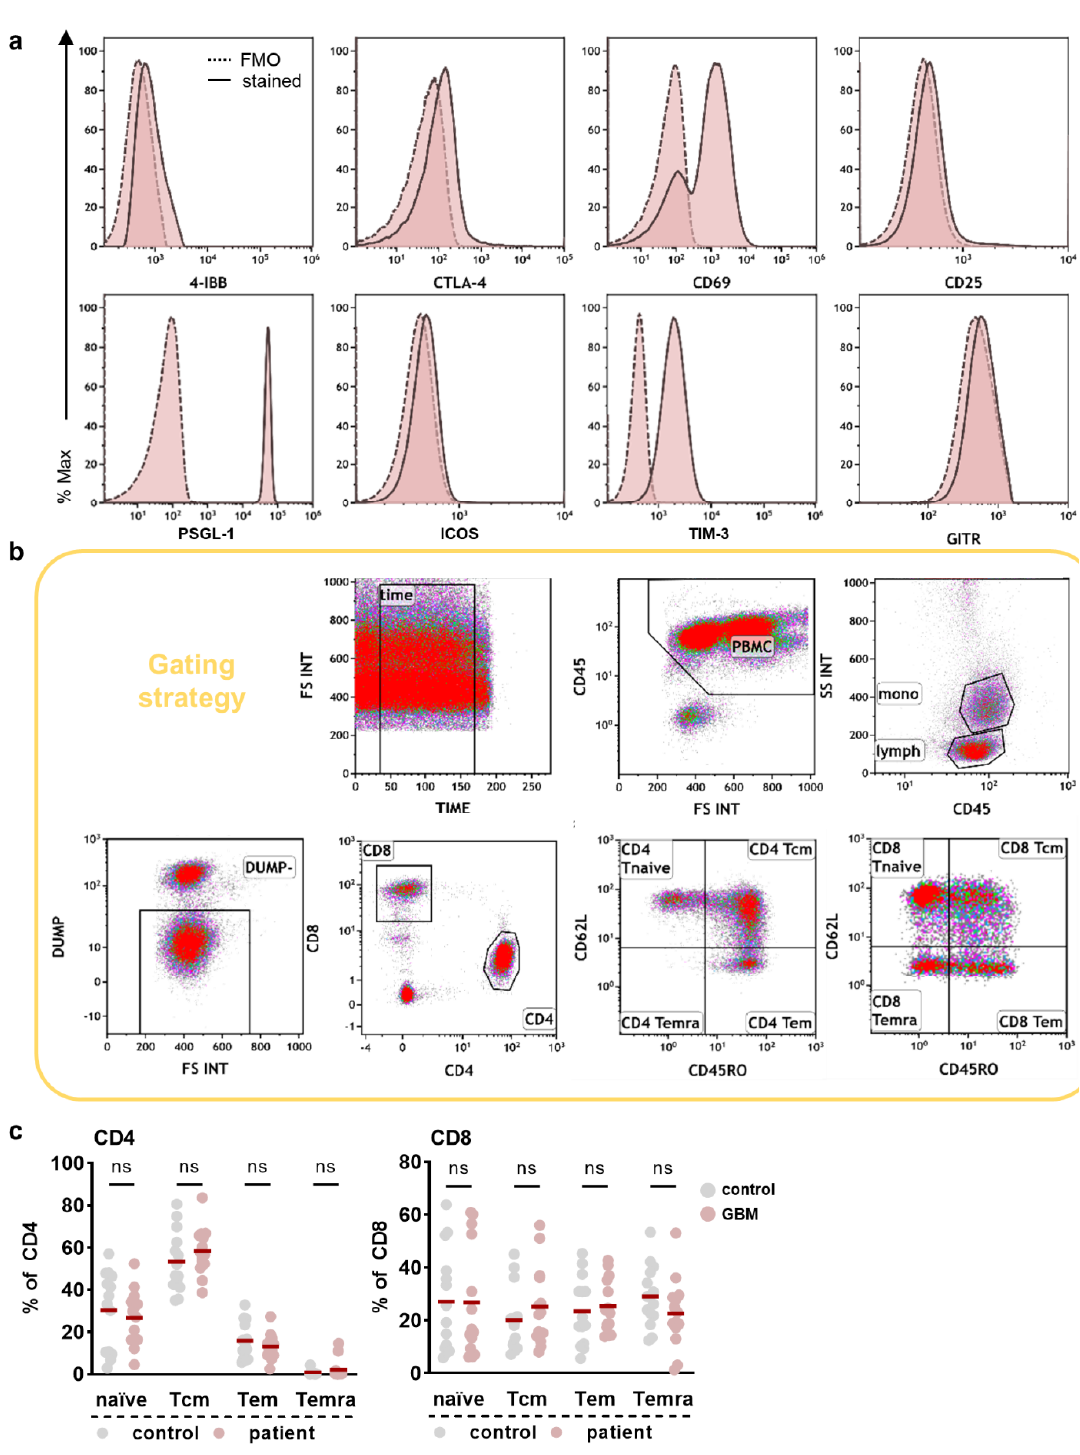
Figure A1. Immunophenotyping of PBMCs in glioblastoma patients and healthy individuals. ( a ) Flow cytometry histograms showing isotype controls and stained circulating myeloid cells; ( b ) representative gating strategy for identification of myeloid and T cell subsets; ( c ) Circulating T cell subset frequencies in glioblastoma patients compared to healthy controls. Statistical analysis was performed using paired t -test. ns = non-significant. cm = central memory. em = effector memory. emra = effector memory expressing CD45RA.